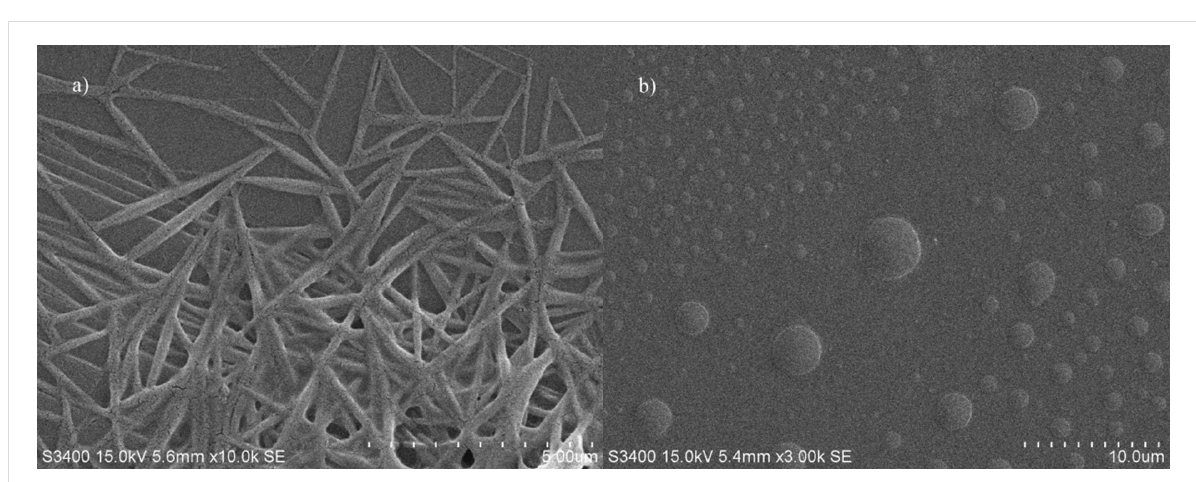
Figure 4: SEM images of the microstructure a) obtained by the self-assembled compound 3 in CHCl 3 on the surface of mica and then b) treated with UV light (365 nm).